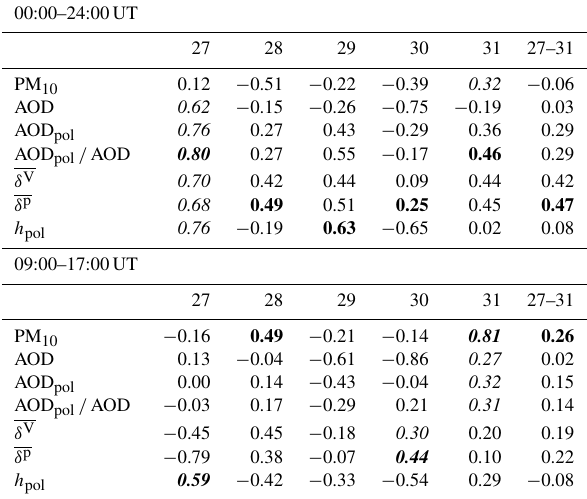
Table 4. Idem as Table 2 for Pinus .